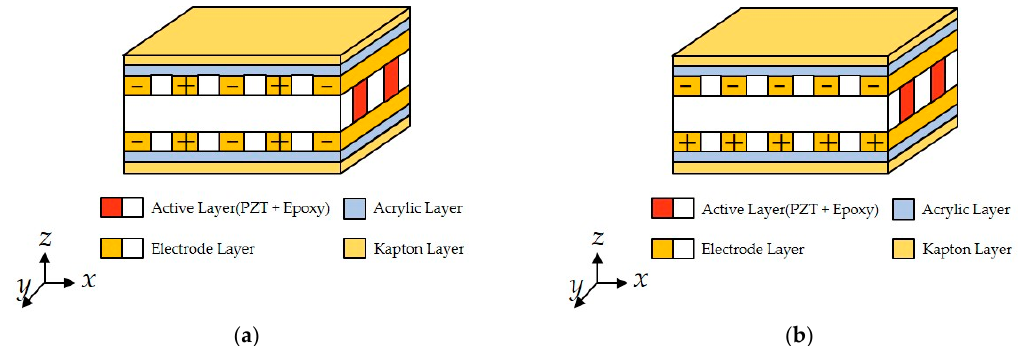
Figure 1. The structure chart of the macro fiber composite (MFC). ( a ) The P1 type of MFC; ( b ) The P2 type of MFC.